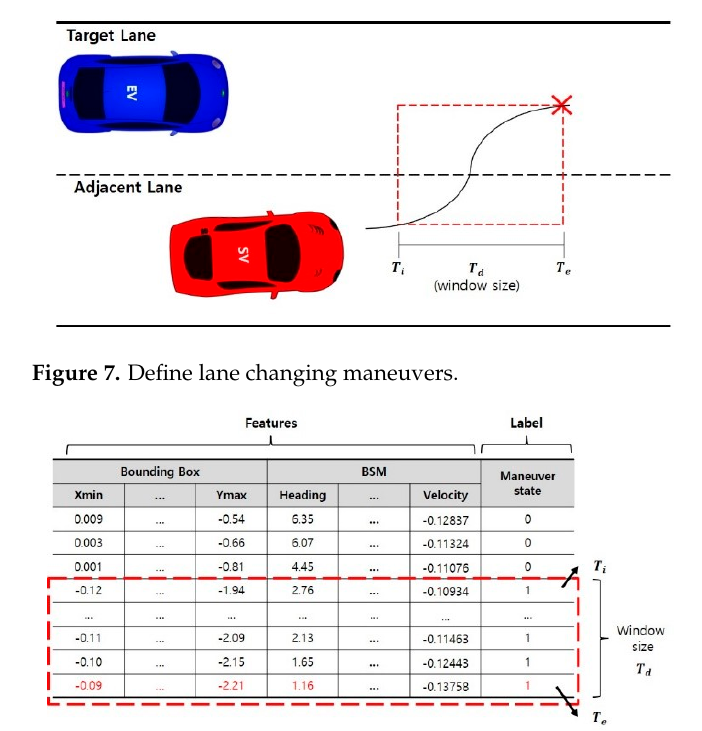
Figure 8. Example dataset for lane change prediction.